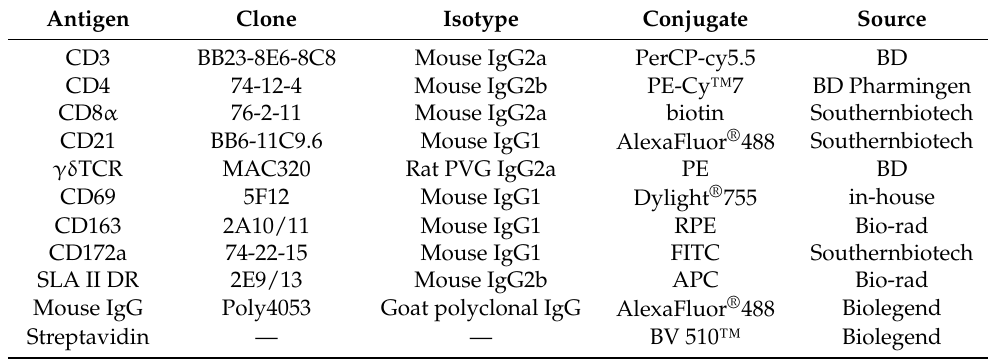
Table 2. Antibodies used in this